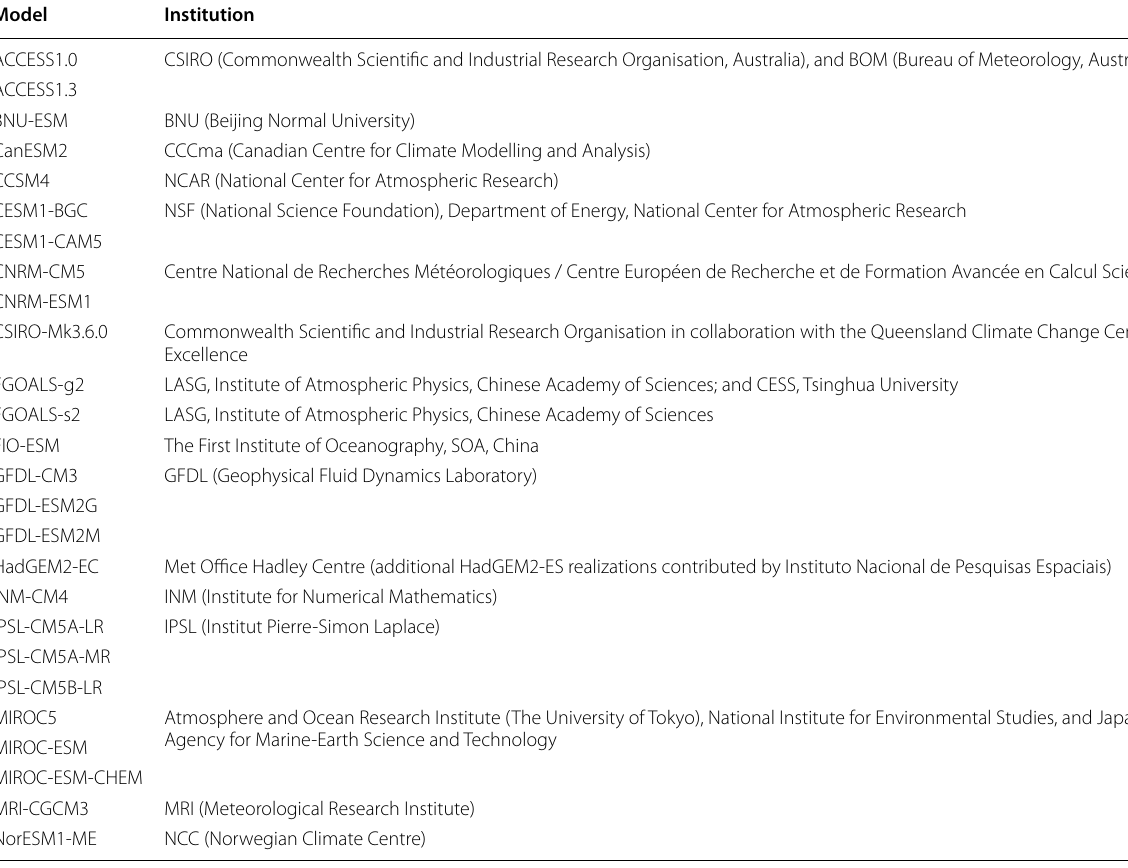
average of different numbers of CMIP5 (see Additional file 1: Table S1) also shows similar patterns (see Addi- tional file 1: Figs. S2 and S3). The N 2 O, CH 4 , CFC-11, and CFC-12 volume mixing ratios of all the above experi- ments are set to be the same as CTL at 319, 1774 ppb, 251, and 358 ppt in 2005 values from Intergovernmental Panel on Climate Change (IPCC) (2007) to avoid impacts from other greenhouse gases. The above settings are summarized in Table 1.